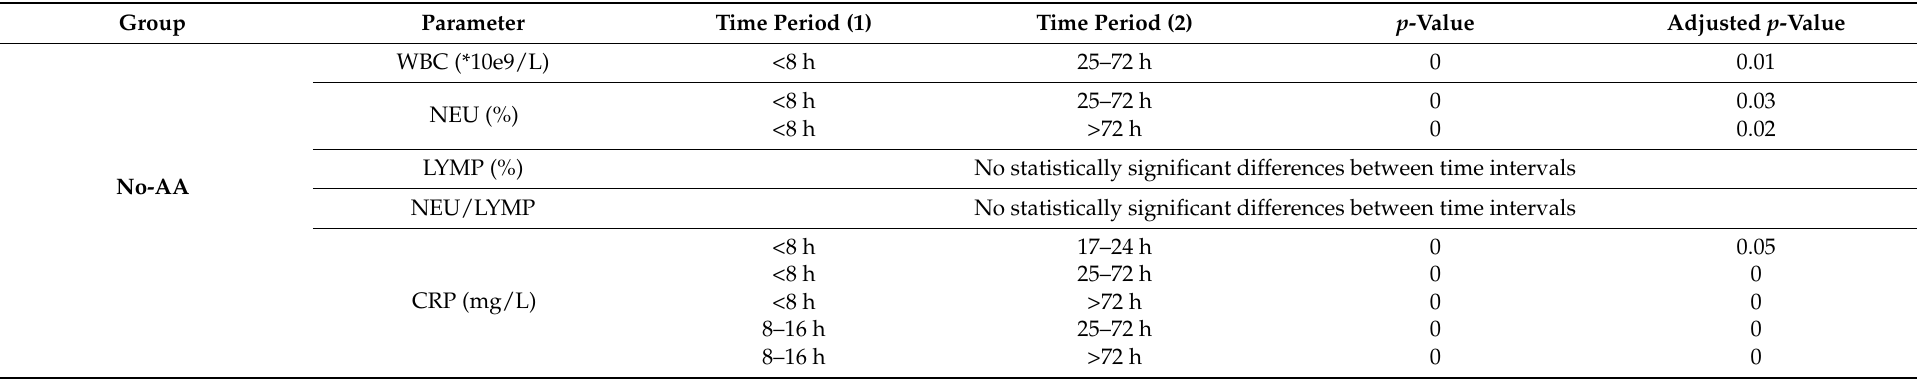
Table 3. Statistically significant differences between different time periods within the groups and their